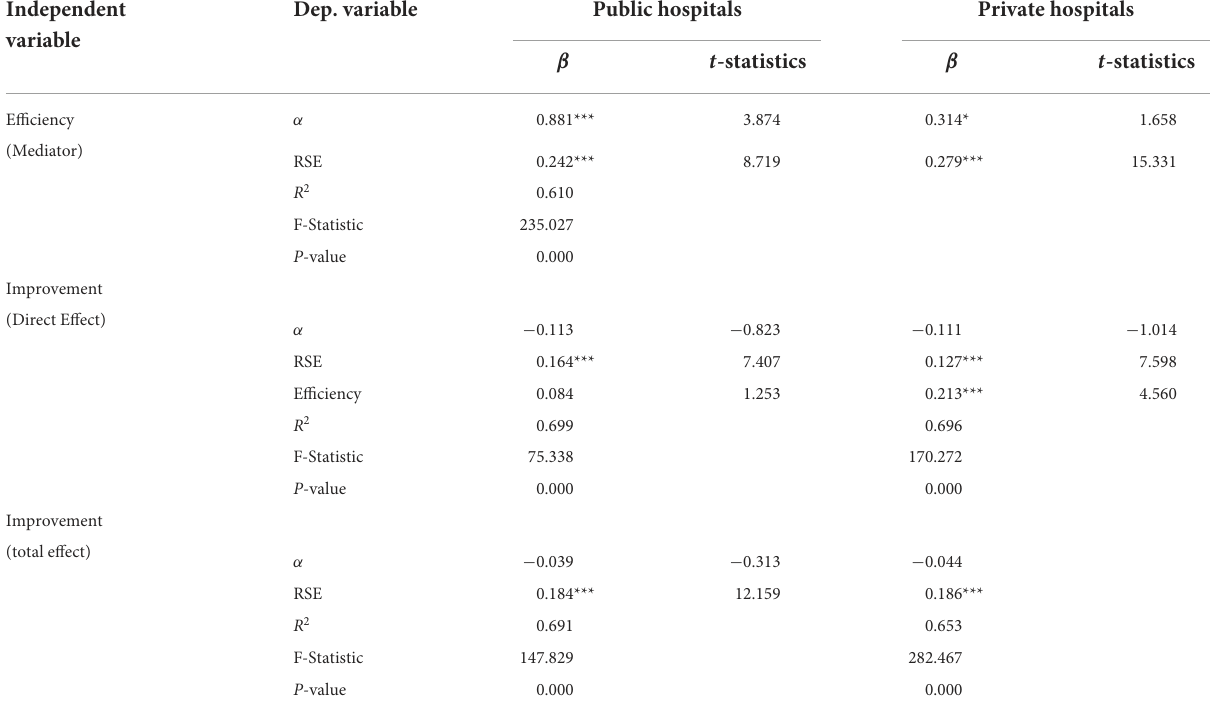
TABLE 6 The mediation role